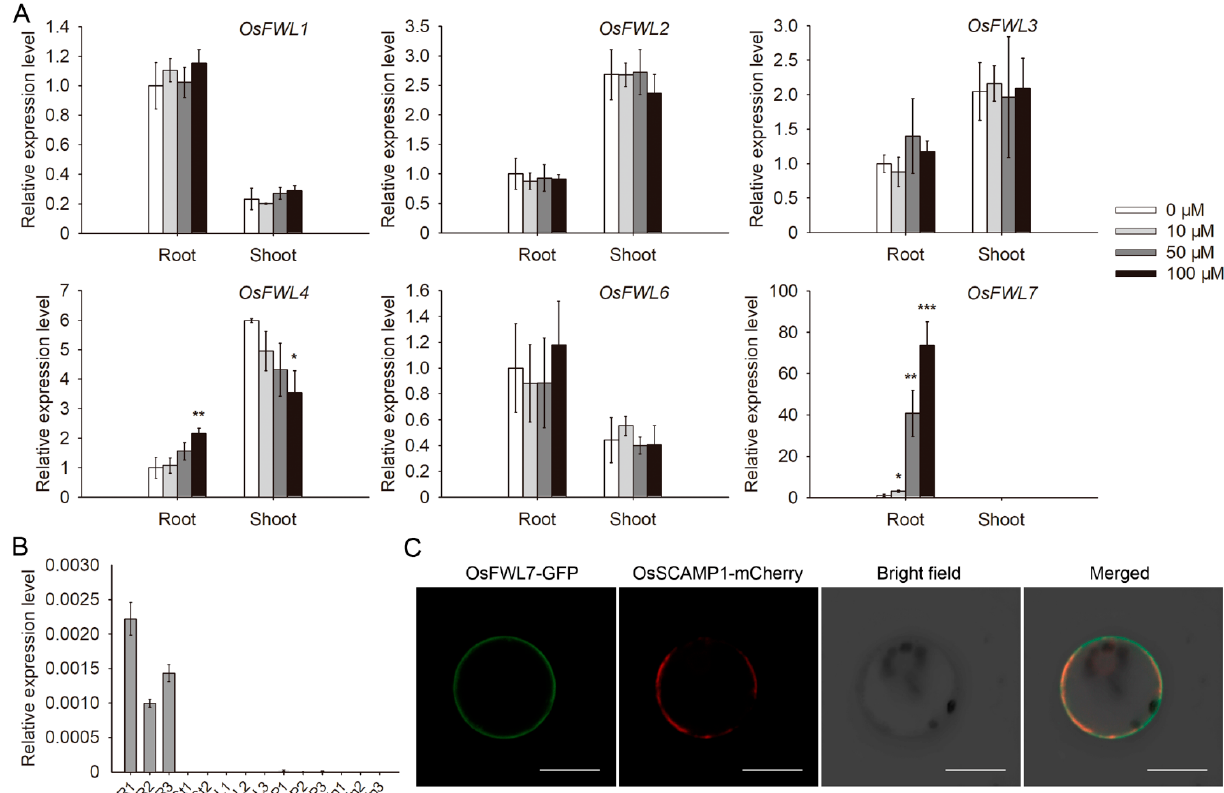
Figure 1. Gene expression profiles and subcellular localization of OsFWL7. ( A ) Expression patterns of six rice FWL genes under treatment with Cd of different concentrations, as determined using RT-qPCR. The rice Actin1 gene was used for normalization of gene expression. Error bars indicate the standard deviation of three biological replicates. * p < 0.05, ** p < 0.01, *** p < 0.001. ( B ) OsFWL7 expression patterns in 14 tissue samples of Oryza sativa L. ssp. japonica variety Zhonghua 11, as determined using RT-qPCR. The tissues used were as follows: seedling, tillering, and heading stage roots (R1–R3); jointing and heading stage stems (St1 and St2); seedling, tillering, and heading stage leaves (L1–L3); 5-, 15-, and 20-cm panicles (P1–P3); and endosperms 5, 14, and 21 days after pollination (En1–En3). Error bars indicate the standard deviation of three technical replicates. ( C ) Subcellular localization of OsFWL7. The OsSCAMP1 -mCherry construct was used as the plasma membrane marker. The GFP fluorescence, mCherry fluorescence, bright field, and merged images are shown. Bar = 10 μ m.